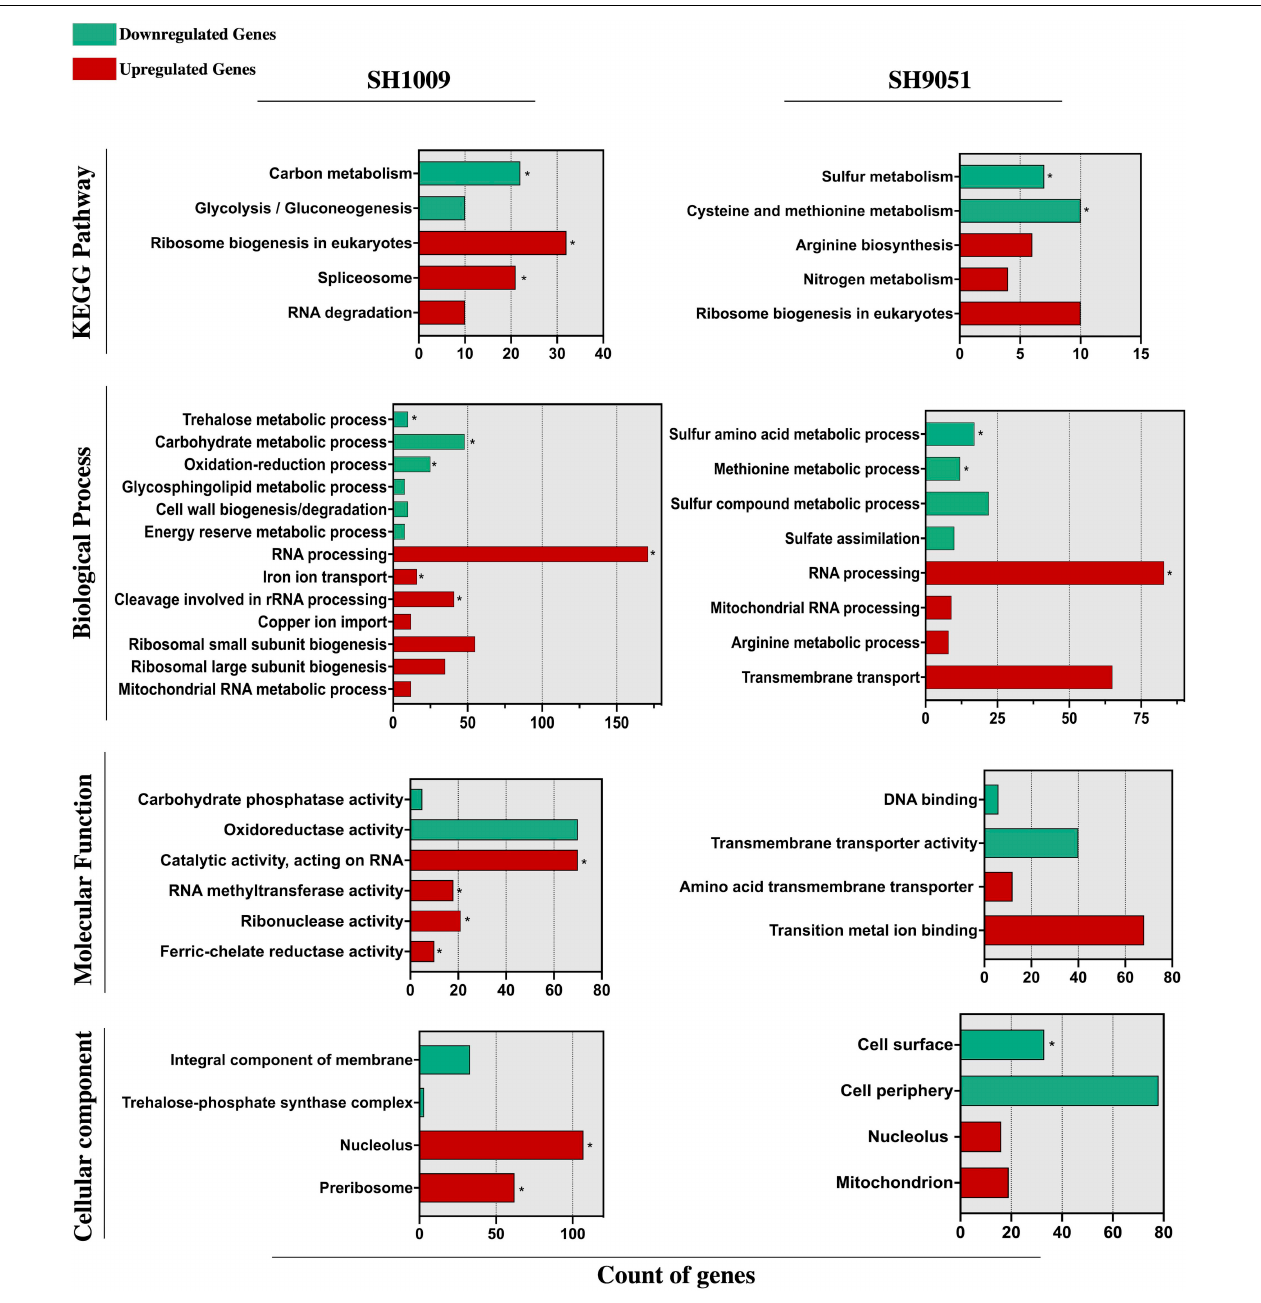
FIGURE 3 | Functional enrichment analysis of KEGG pathway and gene ontology (biological process, molecular function, and cellular component) categories of significantly differential genes (FDR ≤ 0.05 and fold change ≥ 1.5) down- and up-regulated in response to aurones SH1009 and SH9051 treatment. TermFinder and FungiDB were used to find the significantly enriched KEGG/GO terms using GO categories based on a hypergeometric testing in the C. albicans SC5314 annotation with FRD ≤ 0.05 as a cutoff significant value. Green and red bars represent the number of respective down- and up-regulated genes that are clustered in each KEGG/GO term. GO terms within each group are listed according to increasing P values. Asterisks depict the highly significant KEGG/GO categories with P ≤